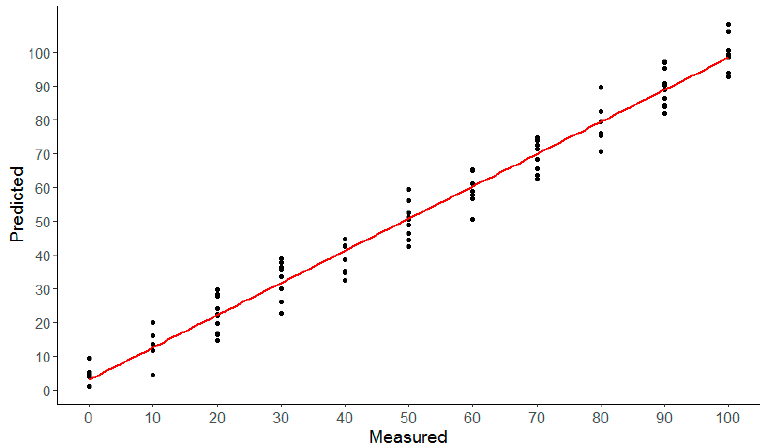
Figure 5. The predicted and true values of Atlantic salmon meat adulteration ratios based on the Cubist model in test sets.